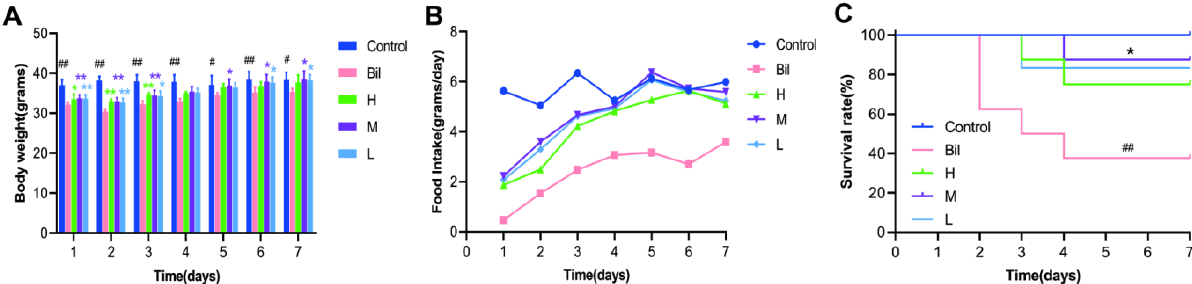
Figure 5. General condition of mice in each group from 1 to 7 days after modeling. ( A ) Body weight; ( B ) Food intake; ( C ) Survival rate. They were divided into control group (Control), Bil group (Bil), and high (H), medium (M) and low (L) dose PGC-CDs groups (5.80, 2.90 and 1.45 mg/kg), n = 8. Compared with the control group, ## p < 0.01, # p < 0.05. Compared with the Bil group, ** p < 0.01, * p < 0.05.